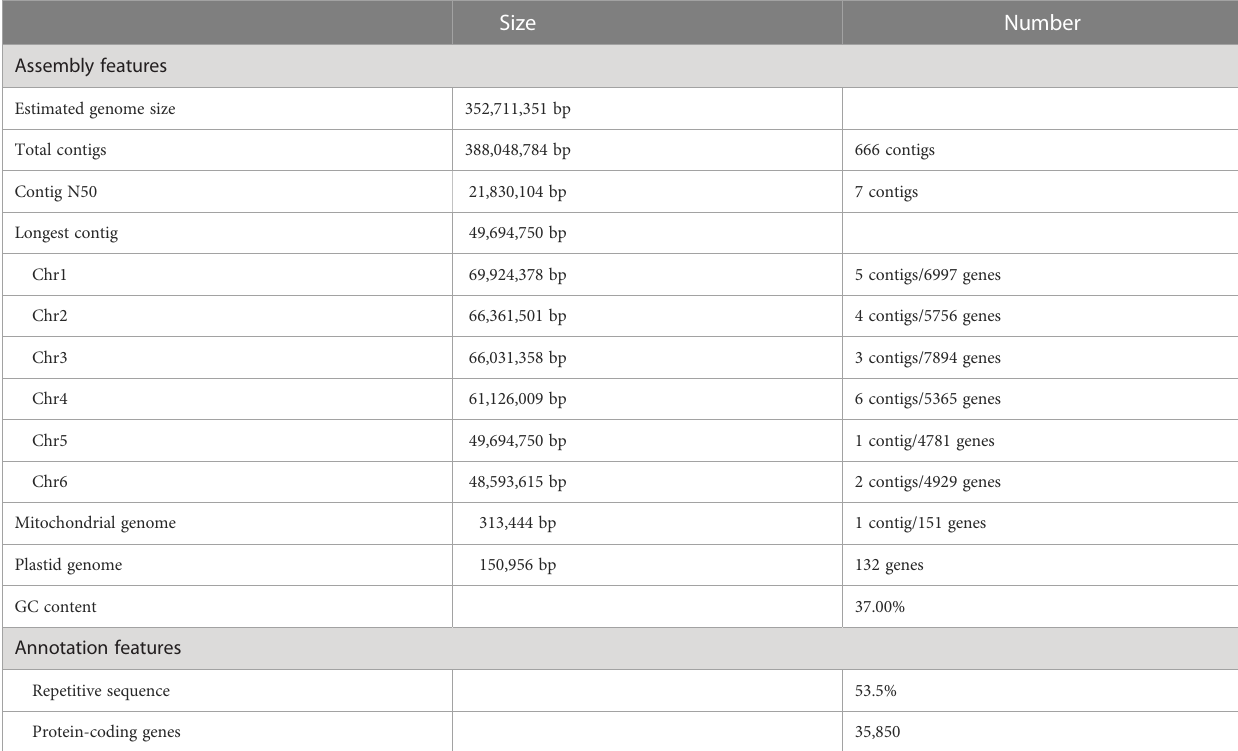
TABLE 1 Summary of chia genome